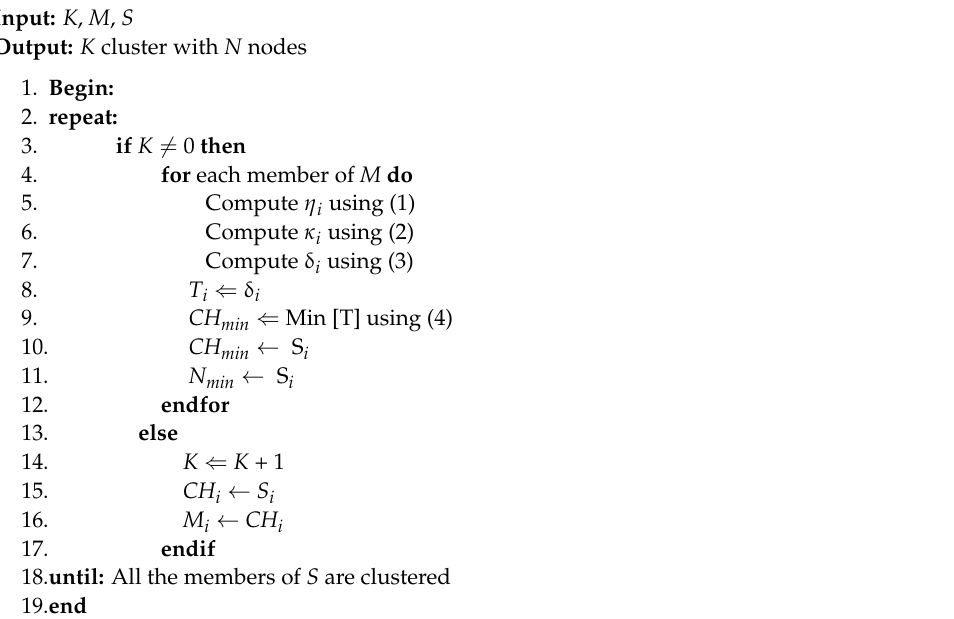
Algorithm 2: Candidate Node Joining a